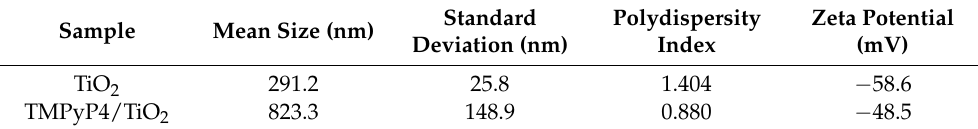
Table 2. The mean hydrodynamic size and zeta potential of the samples. Standard Polydispersity Zeta Potential Sample Mean Size (nm) Deviation (nm) Index (mV) TiO 2 291.2 25.8 1.404 − 58.6 TMPyP4/TiO 2 823.3 148.9 0.880 −